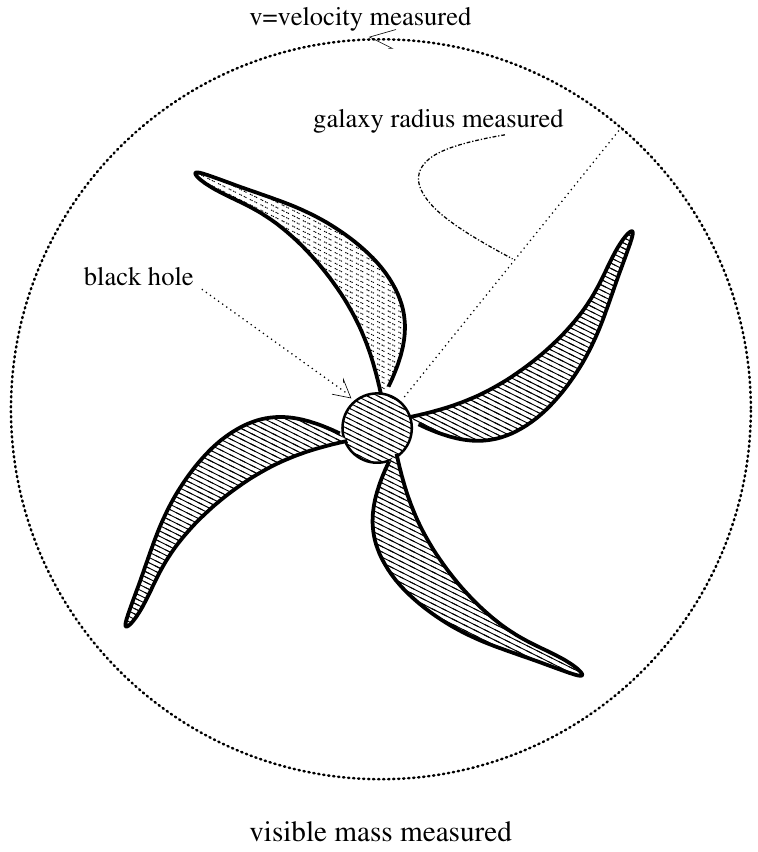
Figure 5. Radius, velocity and mass of the Milky Way